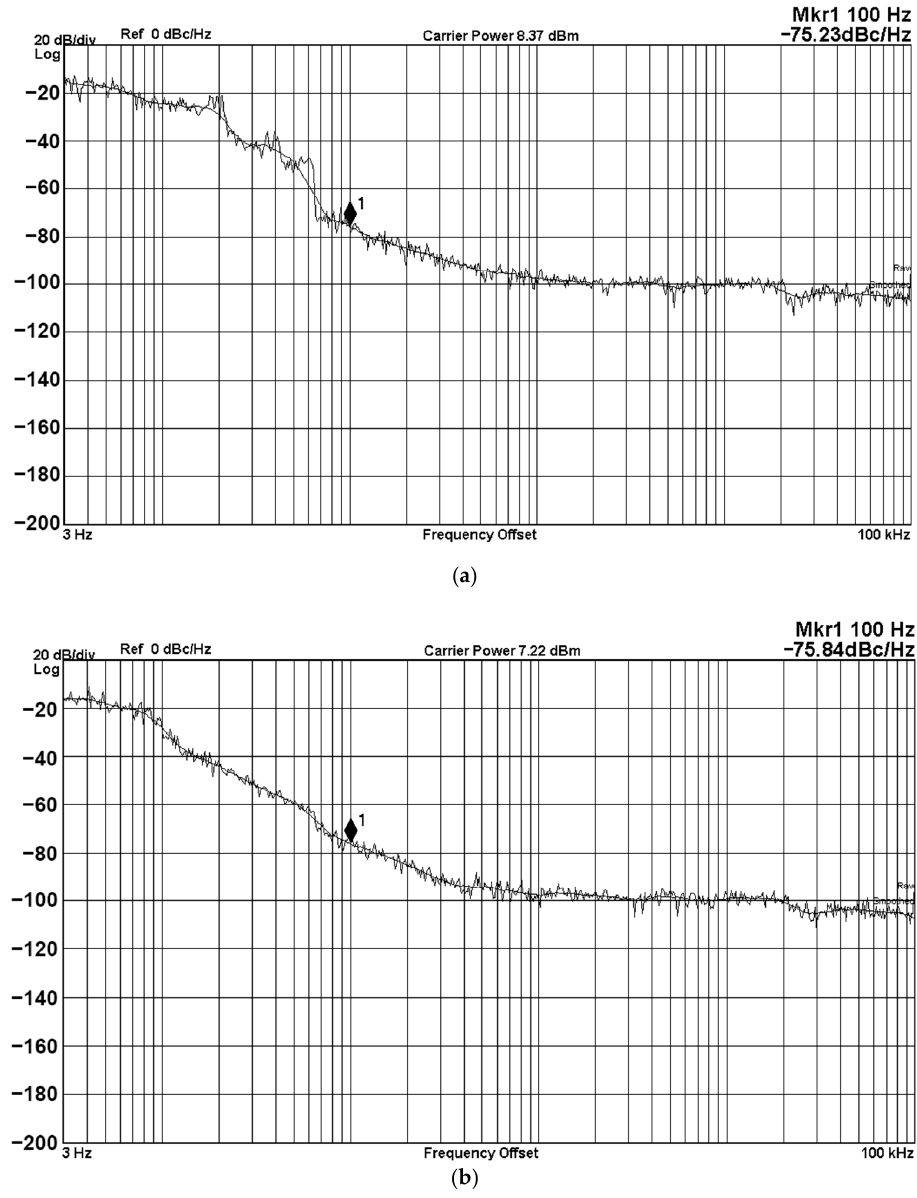
Figure 24. Phase noise performance with different frequency offsets measured from 3 Hz offset frequency. ( a ) V o1 output phase noise; and ( b ) V o2 output phase noise.